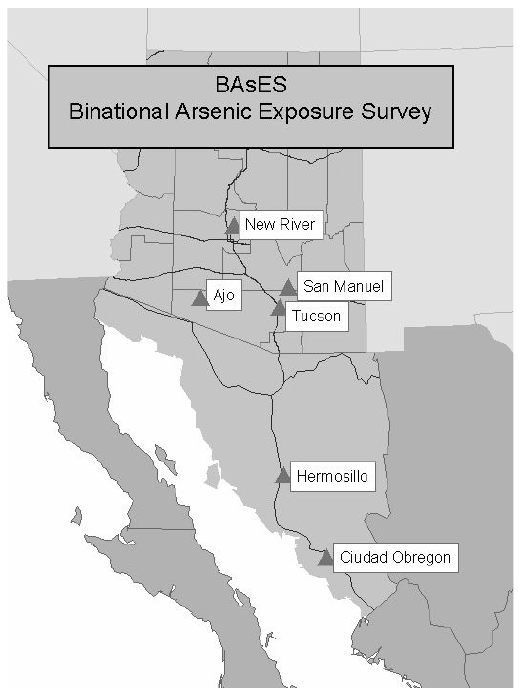
Figure 1. BAsES Recruitment